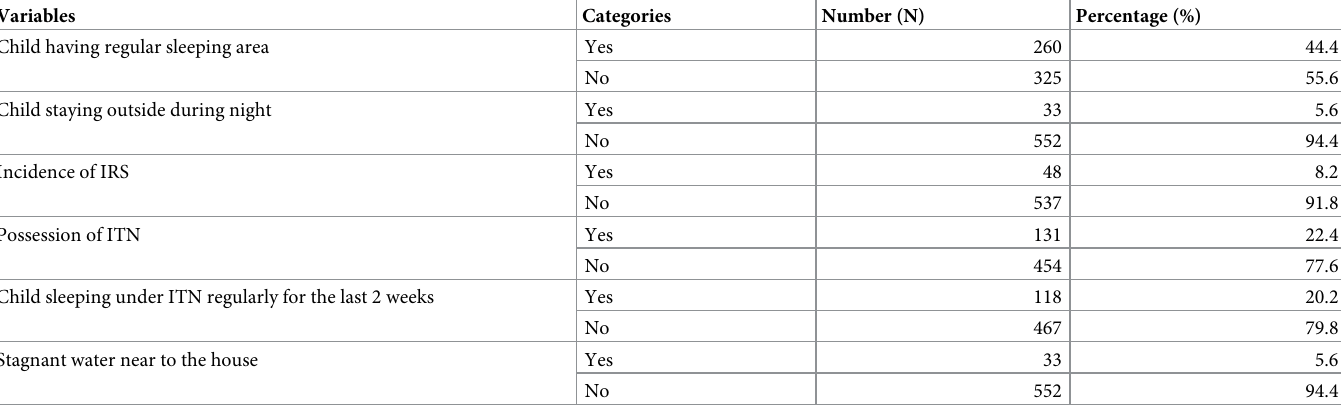
Table 2. IRS, LLIN, and environmental characteristics of study participants, Wogera district, northwest Ethiopia,